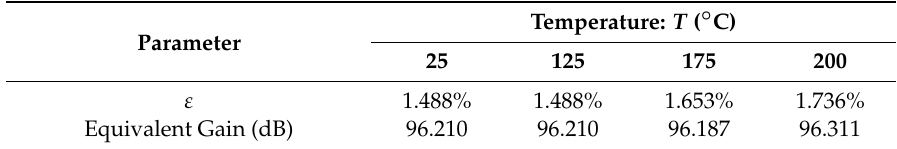
Table 5. Relative nonlinear errors and equivalent gains of the digital lock-in amplifier at different temperatures. Temperature: T (°C) Parameter 25 125 175 200 ε 1.488% 1.488% 1.653% 1.736% Equivalent Gain (dB) 96.210 96.210 96.187 96.311